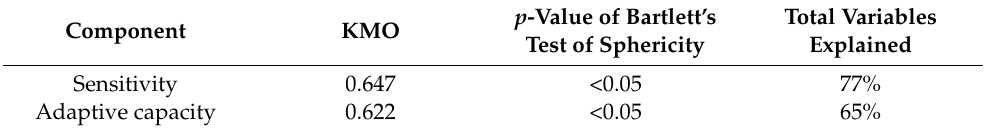
Table 3. Effectiveness test of PCA.